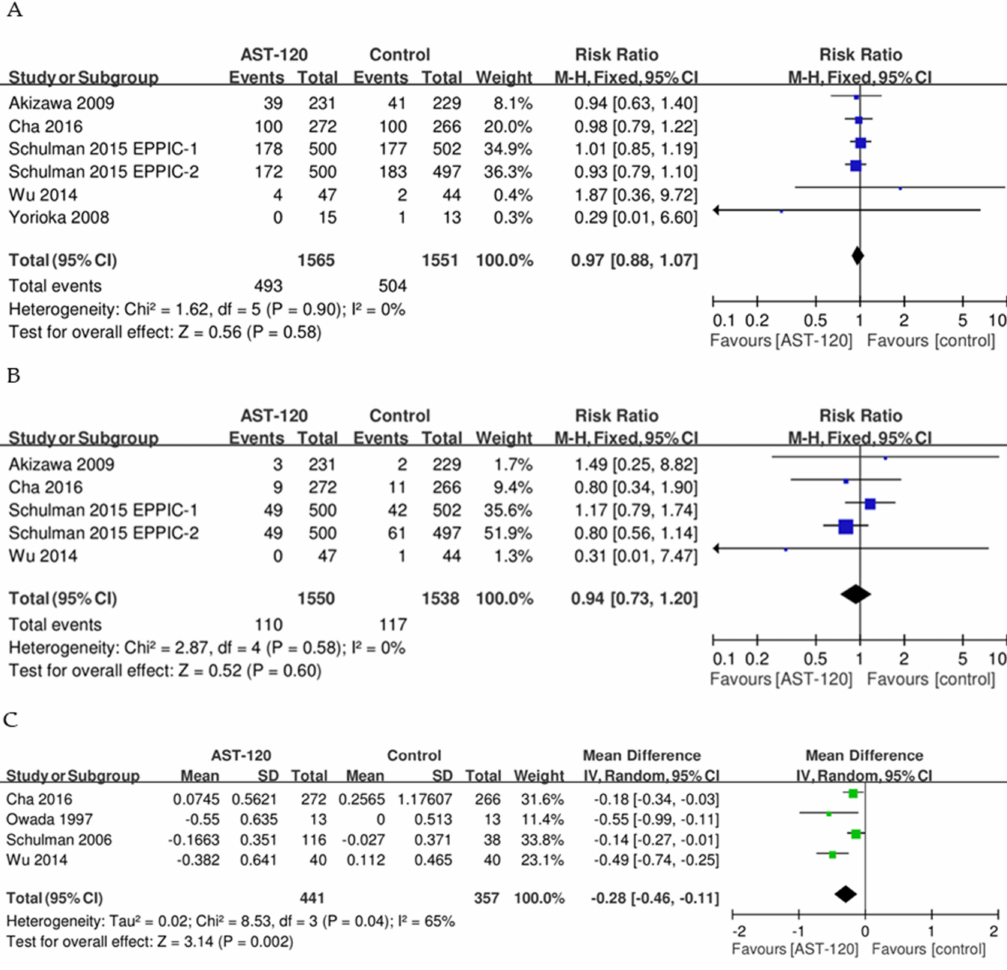
Figure 3. Result of primary outcomes for comparison between AST-120 and control groups. ( A ) Composite of renal outcome; ( B ) All-cause mortality; ( C ) Change in serum indoxyl sulfate levels. All-Cause